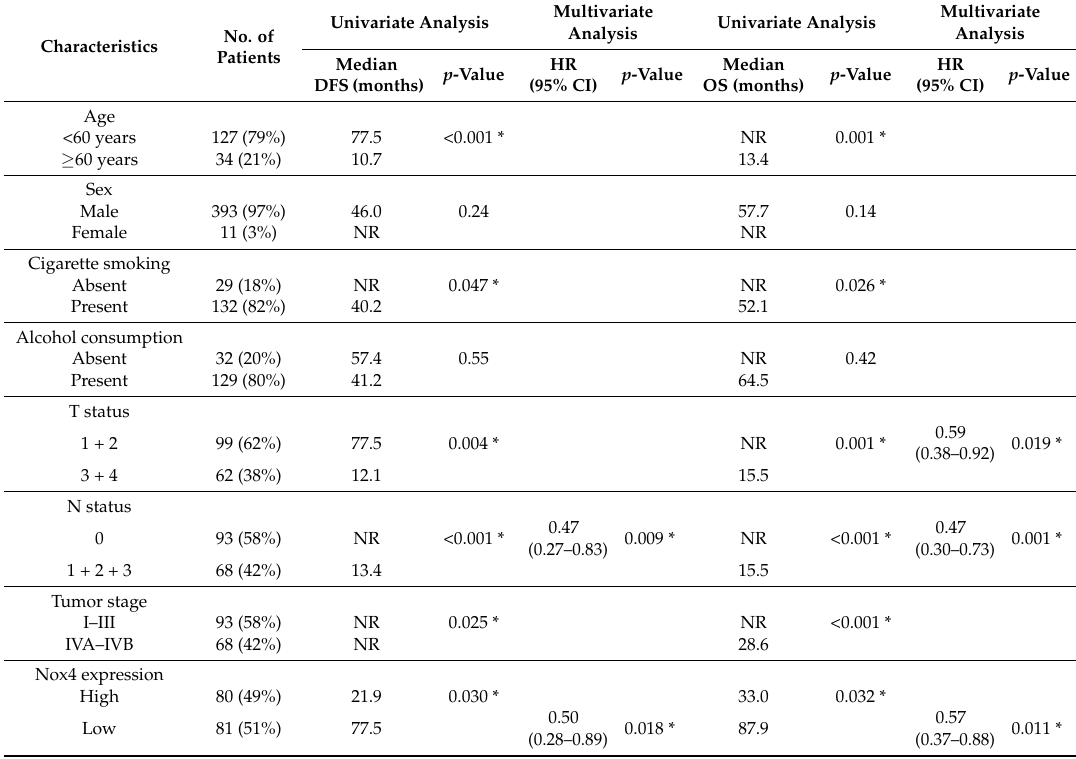
Table 3. Univariate and multivariable analysis of disease-free survival and overall survival in in 161 patients with oral tongue squamous cell carcinoma receiving surgical resection.